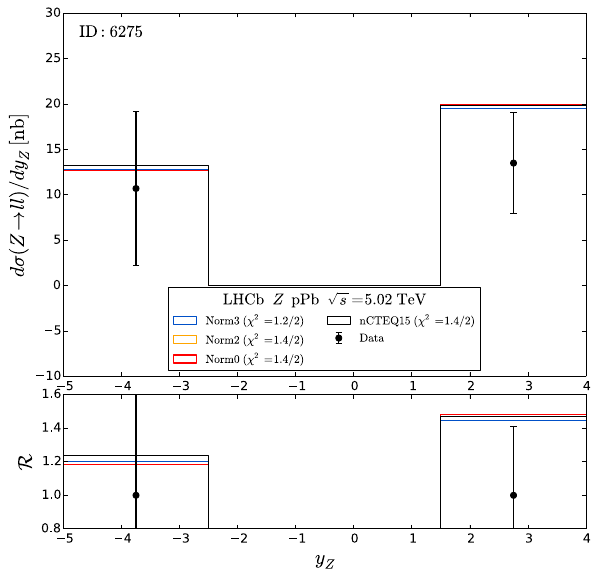
Fig. 6 Comparison of data with theory for LHCb Z production (ID 6275). The normalization shifts are applied to the theory so we can compare all the results on a single plot; the data is